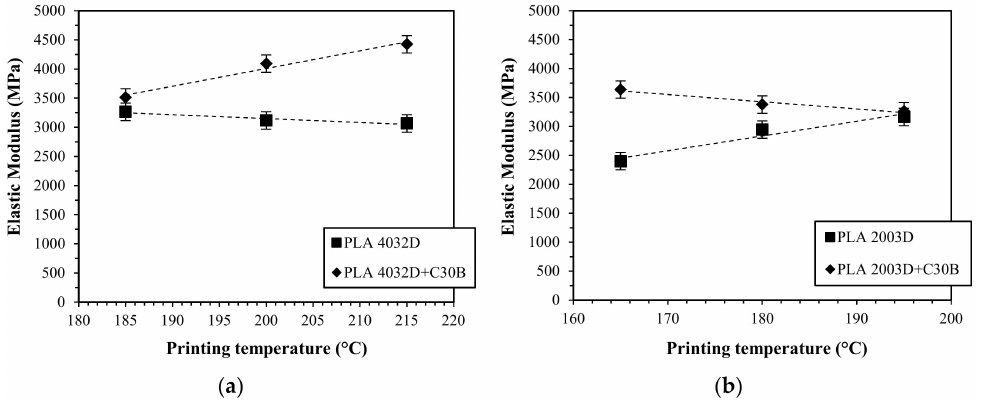
Figure 9. Elastic modulus of the 3D printed samples of PLA 4032D and PLA 4032D+C30B ( a ) and PLA 2003D and PLA 2003D+C30B ( b ) printed at different